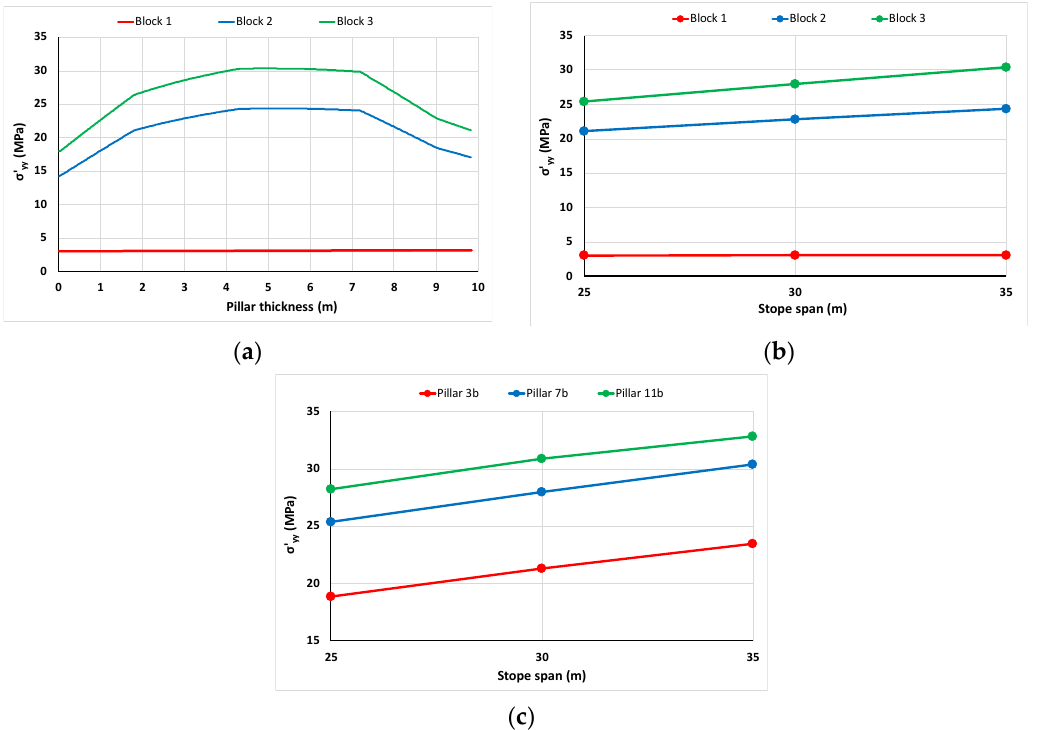
Figure 6. Variation of the normal stress 𝜎 (cid:3052)(cid:3052)(cid:4593) ( a ) along Pillar 7b for 35 m stope span and each mining stage, ( b ) at the middle of Pillar 7b for each mining stage vs. the stope span. ( c ) Variation of the normal stress 𝜎 (cid:3052)(cid:3052)(cid:4593) at the middle of the three pillars for Block 3 mining stage vs. stope span.